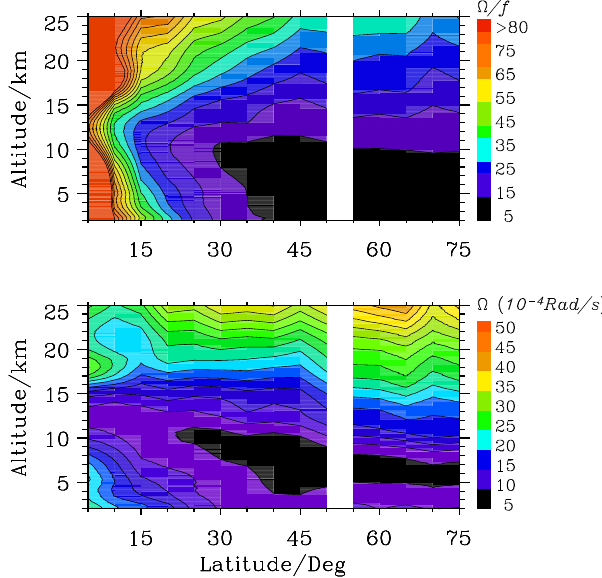
Figure 5. Latitudinal and vertical variations of the averaged ratio of (cid:127) (upper panel) and intrinsic frequency (cid:127) in 10 − 4 rads − 1 (lower f panel) derived from the potential energy density and vertical fluctu- ation energy density. The blanks denote no